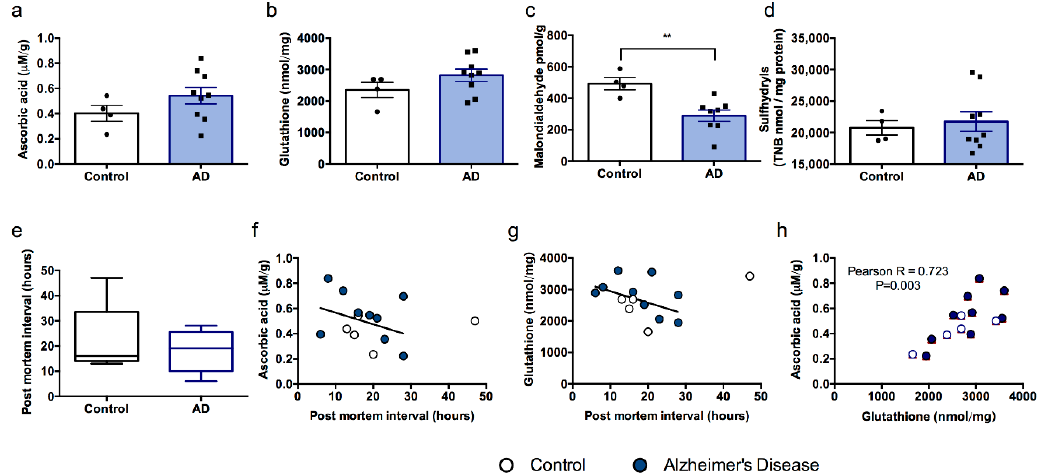
Figure 4. Antioxidant and oxidative stress markers do not vary according to disease or PMI in human samples. ( a ) Ascorbic acid, ( b ) total glutathione, ( c ) malondialdehyde, ( d ) sulfhydryls and ( e ) post-mortem interval (PMI) for all samples. Non-significant trends to decreasing antioxidant markers in human brain according to PMI for ( f ) ascorbic acid and ( g ) glutathione. ( h ) Ascorbic acid and glutathione levels were significantly correlated with each other. ** Control different from AD (Alzheimer’s Disease) cases, p < 0.01. Table 2. 2-tailed correlations between PMI and biochemical measures in human brain tissue.